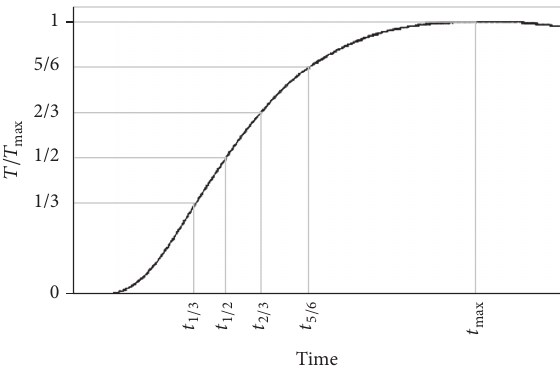
Figure 3: Definition of times, 𝑡 1/3 ,𝑡 1/2 ,𝑡 2/3 , 𝑡 5/6 and 𝑡 max , used in Parker and Degiovanni